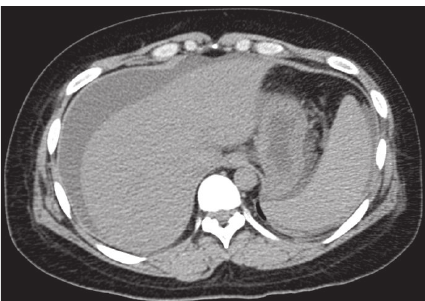
Figure 1: Computed tomography on admission showed atrophic liver and mild splenomegaly. There was moderate ascites but no evidence of cirrhosis.